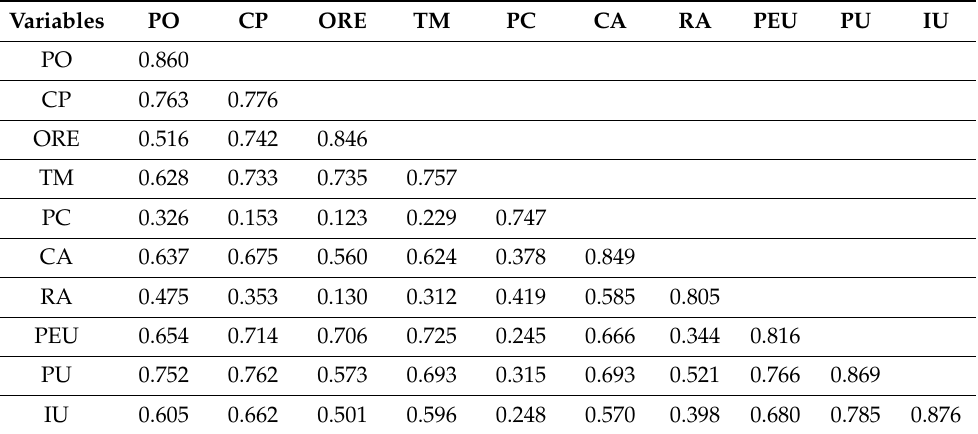
Table 4. Discriminant validity of variables.